Question: Condense the content of this figure into a single sentence.
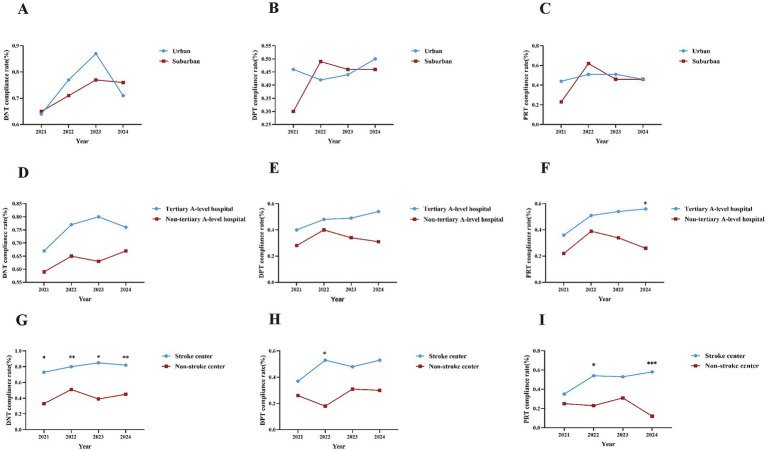
Answer: Temporal trends in compliance rates of reperfusion treatment indicators stratified by different hospital categories (2021–2024). (A–C) Compliance rates for DNT, DPT, and PRT by geographic region (urban vs. suburban). (D–F) Corresponding compliance rates stratified by hospital level (tertiary A-level vs. non-tertiary). (G–I) Corresponding compliance rates stratified by stroke center designation (stroke center vs. non-stroke center). Asterisks indicate statistically significant differences (* p < 0.05, ** p < 0.01, *** p < 0.001). DNT, door-to-needle time; DPT, door-to-puncture time; PRT, puncture-to-recanalization time.